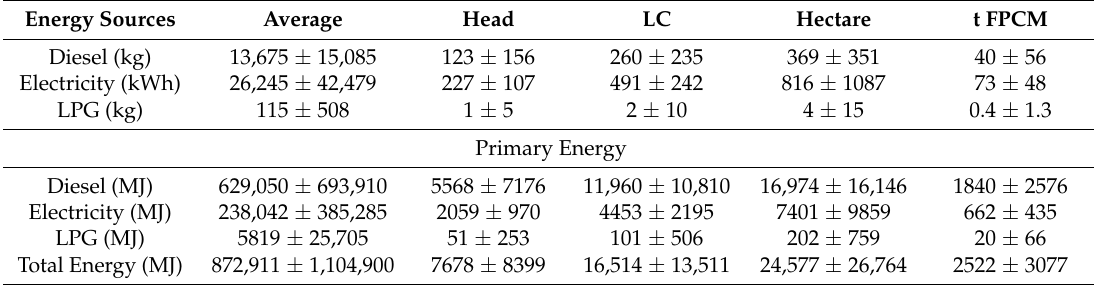
Table 1. Energy data summary on a yearly basis, averages and standard deviation (N =